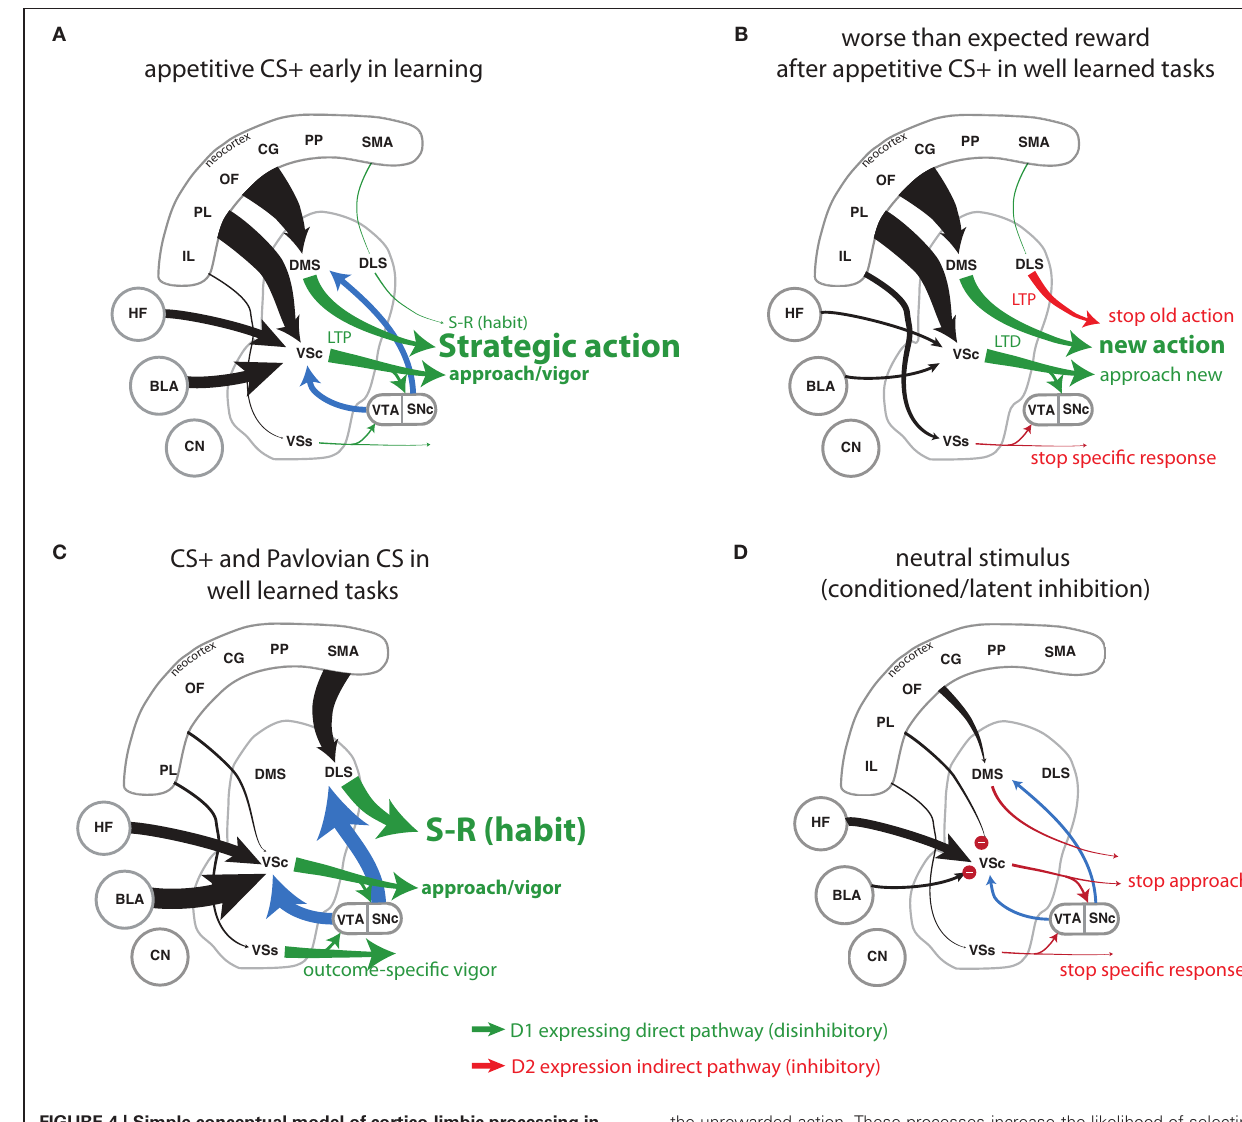
the unrewarded action. These processes increase the likelihood of selecting a new action in the future. (C) Presentation of a Pavlovian CS engages a PIT mechanism involving additional activation of BLA, VSs, and dopamine to potentiate the associated S-R response in DLS as well as the general vigor via VSc. (D) Presentation of a CS with no associated reward in an excitatory context causes hippocampus to activate inhibition in the VSc so as to prevent orientation and task engagement. Furthermore, if the animal had previously responded to the CS- and received less reward than expected, LTP in the inhibitory indirect pathway would actively suppress these specific responses. Abbreviations are the same as for Figure 1 , except that connectivity within the hippocampal formation (HF) is not